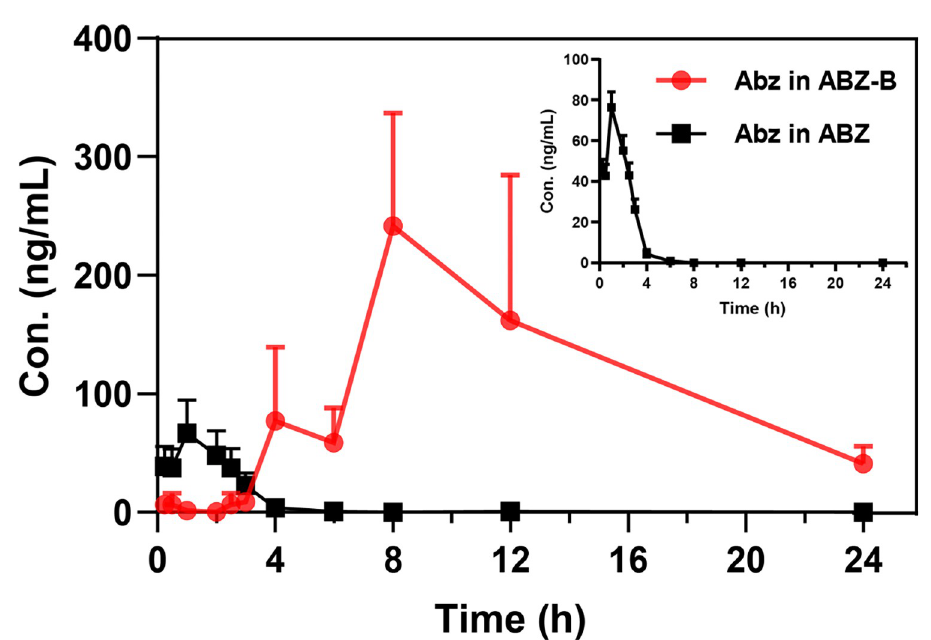
Fig 6. Drug release behavior of ABZ-BA and ABZ in vivo (n = 7).